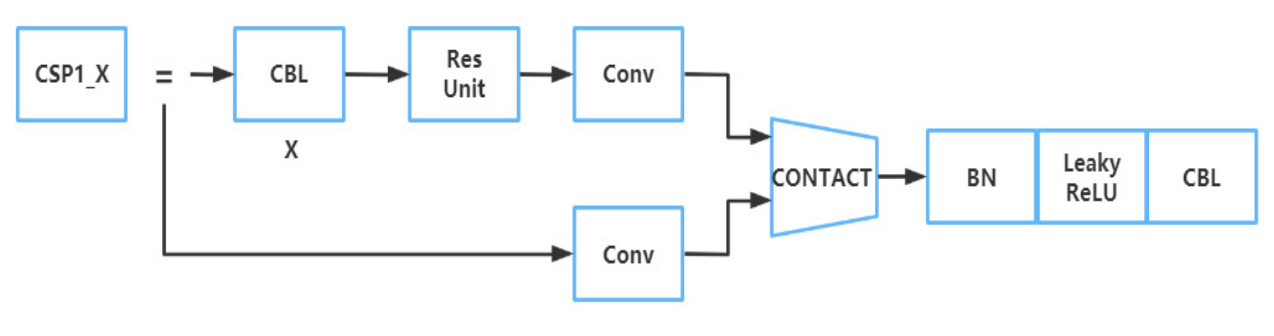
Figure 6. Structure diagram of CSP1_X.